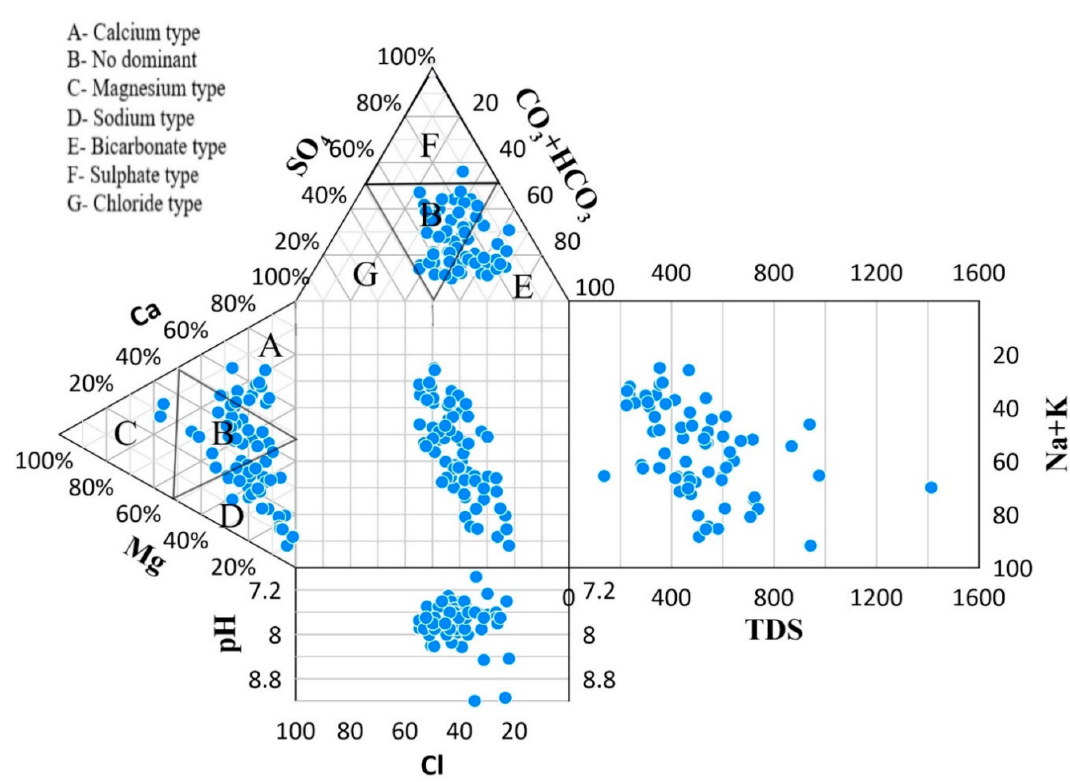
Figure 3. The Durov diagram of groundwater in the Khanewal